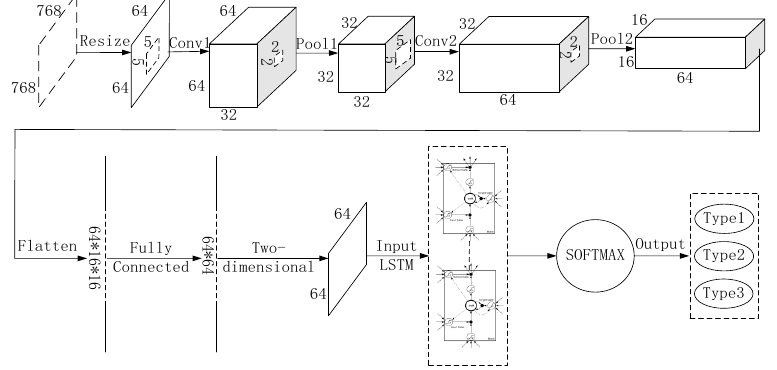
Figure 1. Convolutional neural network and long short-term memory network (CNN–LSTM) algorithm overall